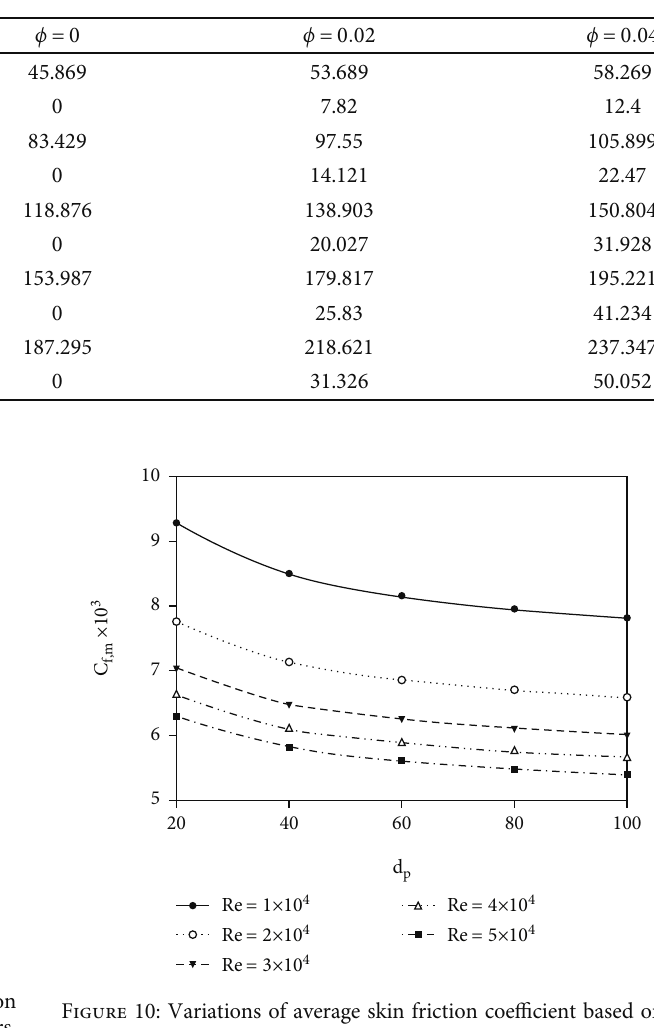
Table 5: Values of average Nusselt and its increase for di ff erent Reynolds ’ numbers and volume fractions.